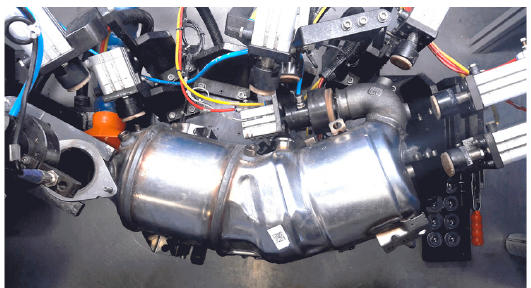
Figure 2. The assembled catalytic converter into the quality cell (courtesy of Marelli Europe SPA Green Technology Systems, Caivano, Italy).